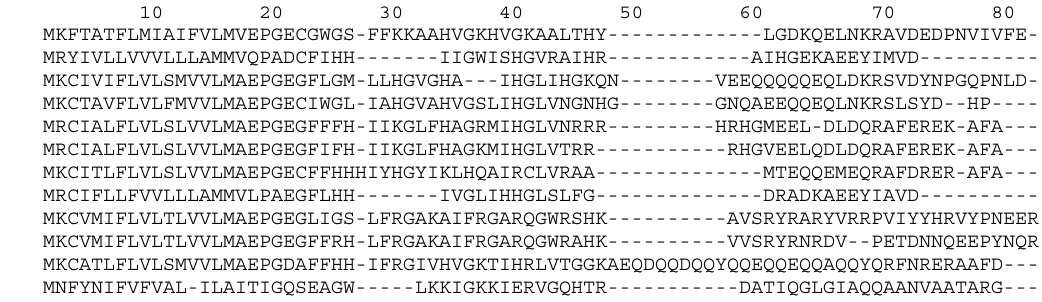
Figure 1. Alignment of piscidins. Mature peptide sequences were obtained from published data and from the PubMed protein database, and were aligned using MacVector